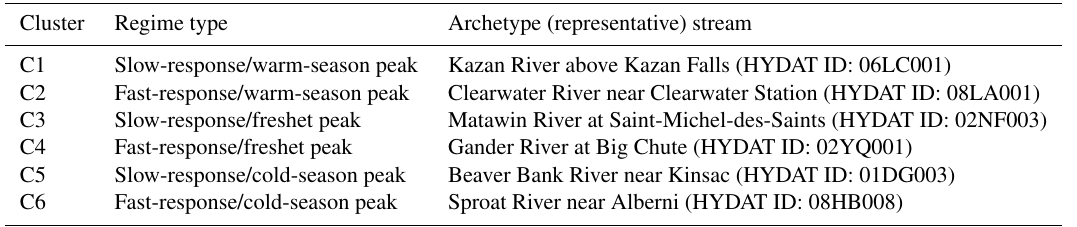
Table 3. Six identified regime clusters along with their labelled regime type and archetype stream. Cluster Regime